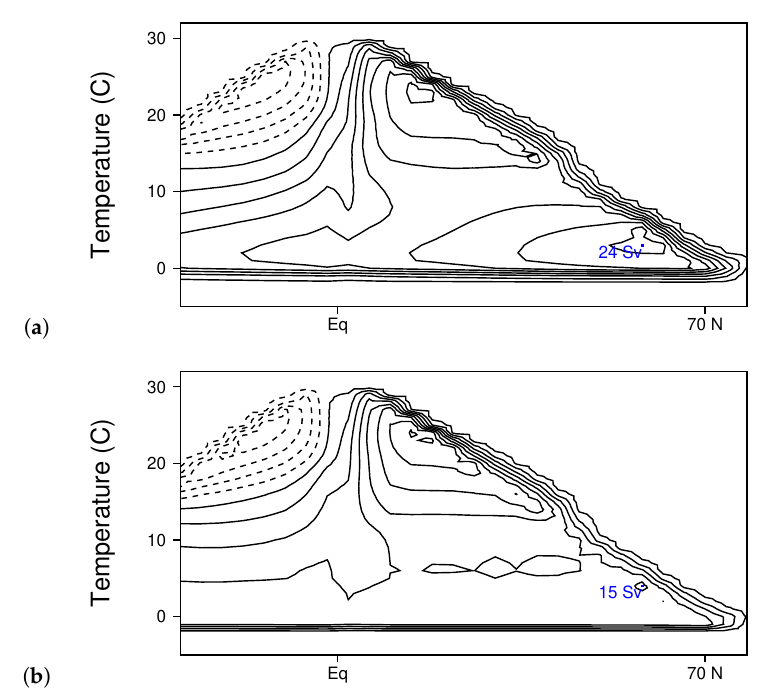
Figure 11. Meridional overturning streamfunction with temperature as a vertical coordinate (3 Sv contour interval). ( a ) Simulation with mixing. ( b ) Simulation without mixing. Positive (negative) contours are drawn with solid (dashed) lines, with contour values ranging from − 10.5 to 22.5